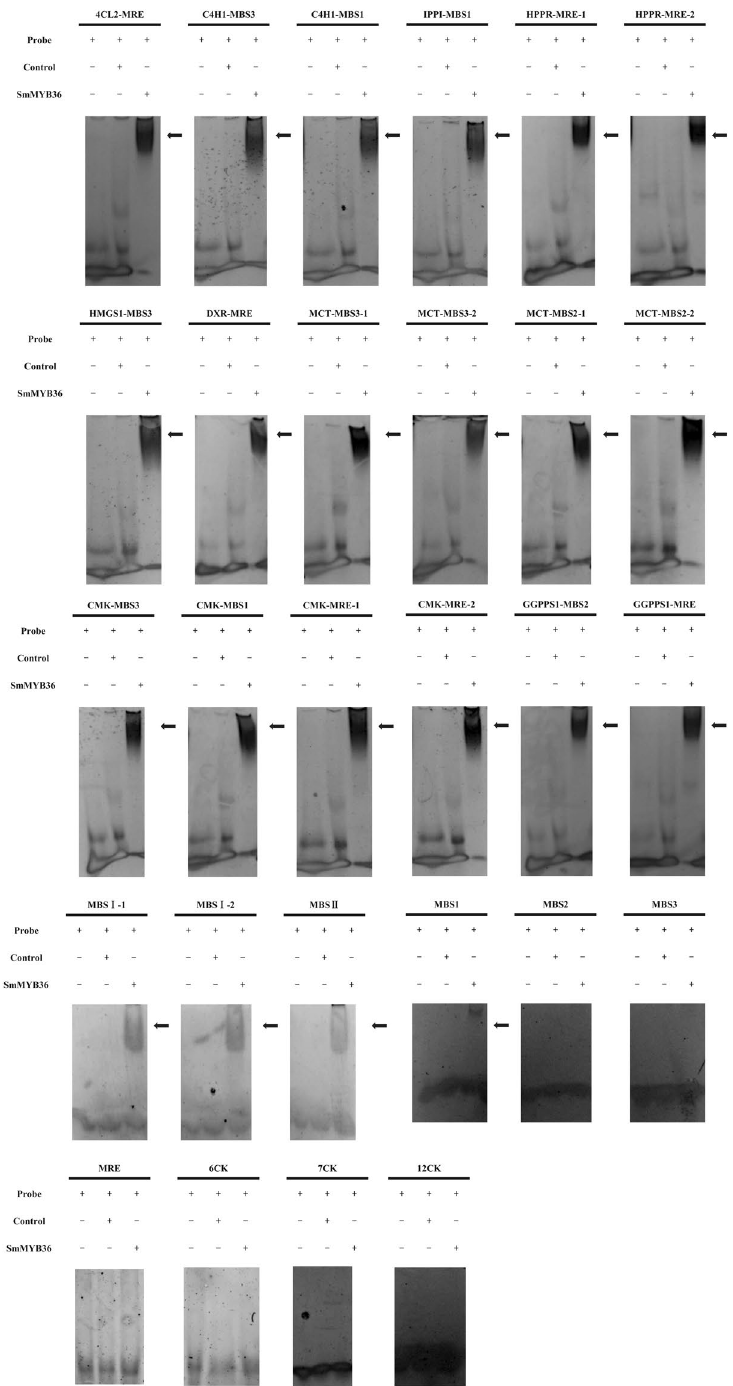
Figure 8. Analysis of SmMYB36 binding to the predicted promoter probes of secondary metabolism pathway genes in S.miltiorrhiza . Arrows indicates the combination between SmMYB36 and